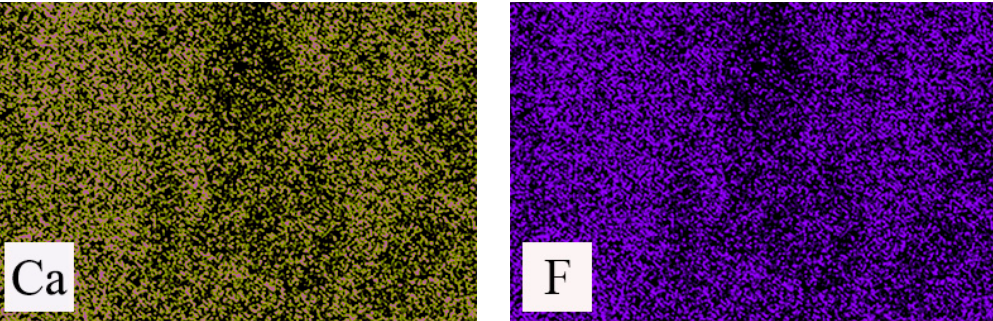
Figure 14. SEM image and corresponding EDS elemental mapping images (Al, Ti, Si, Ca, F) of flank wear of the ATSC10 cutting tool.